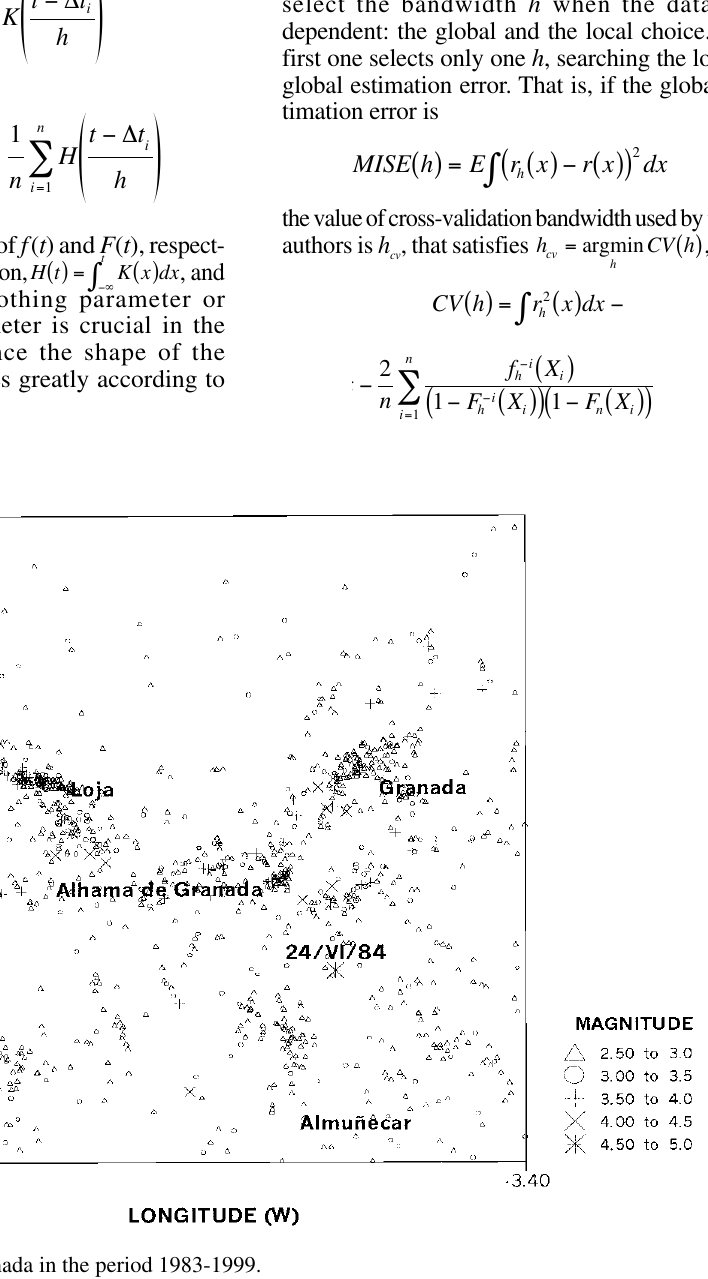
Fig. 1. Seismicity of Granada in the period